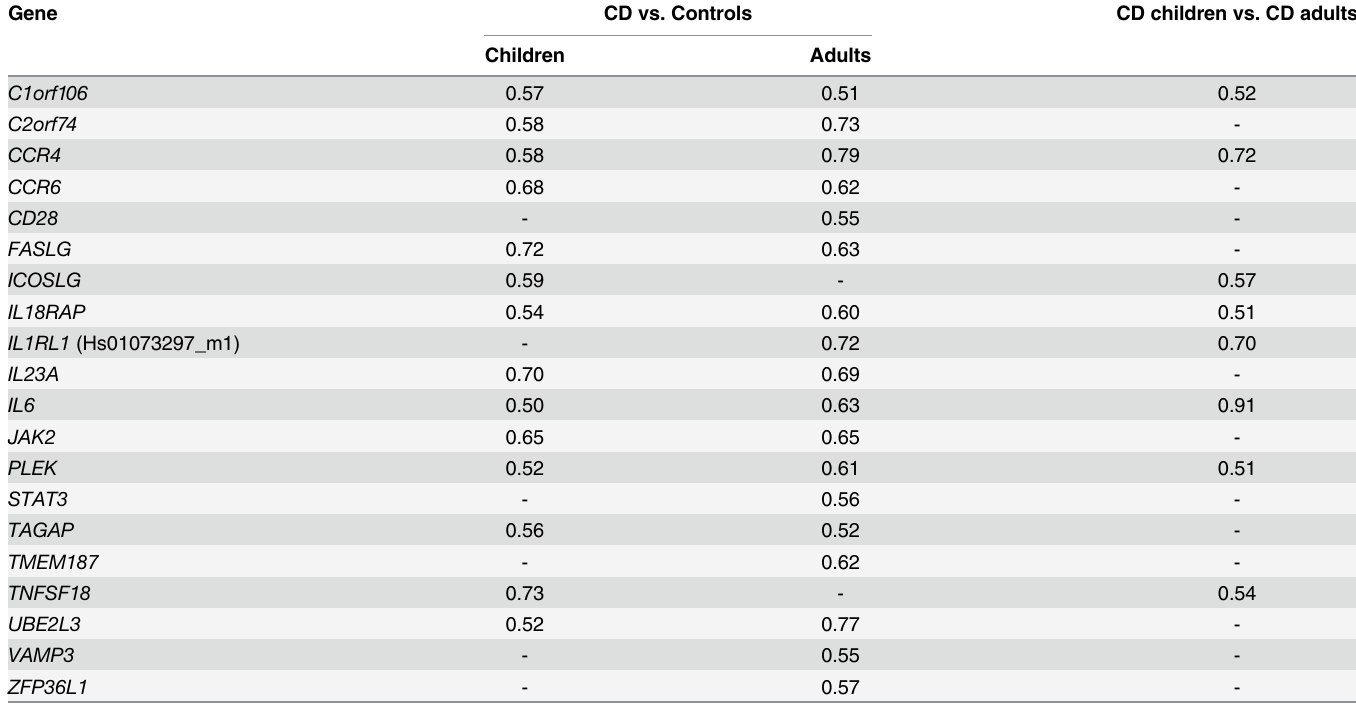
Table 1. Posterior probabilities obtained from the comparison between CD patients and controls stratified according a childhood- or adult-onset and between children and adults with CD. Gene CD vs. Controls CD children vs. CD